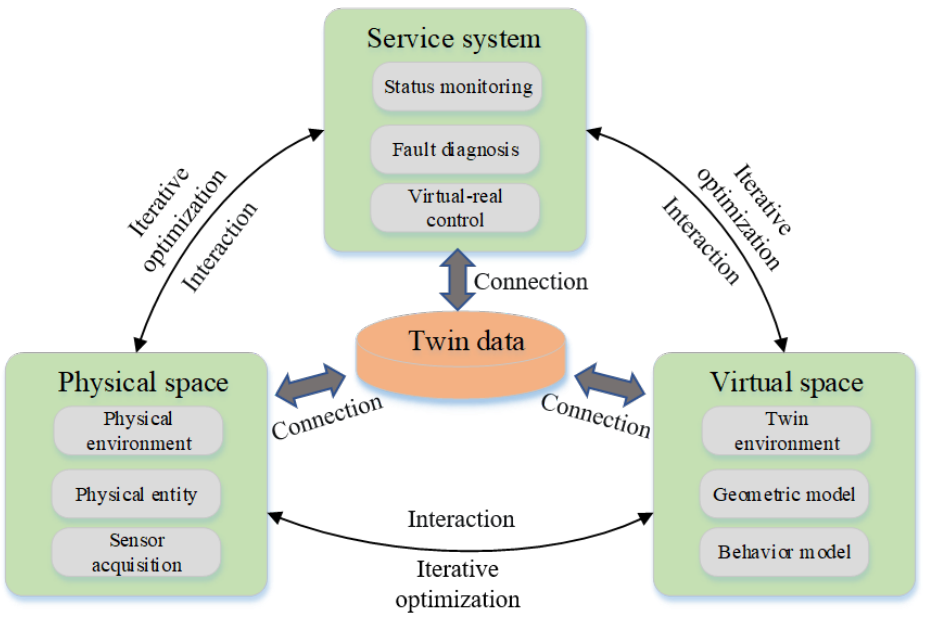
Figure 1. Architecture of the digital twin model.